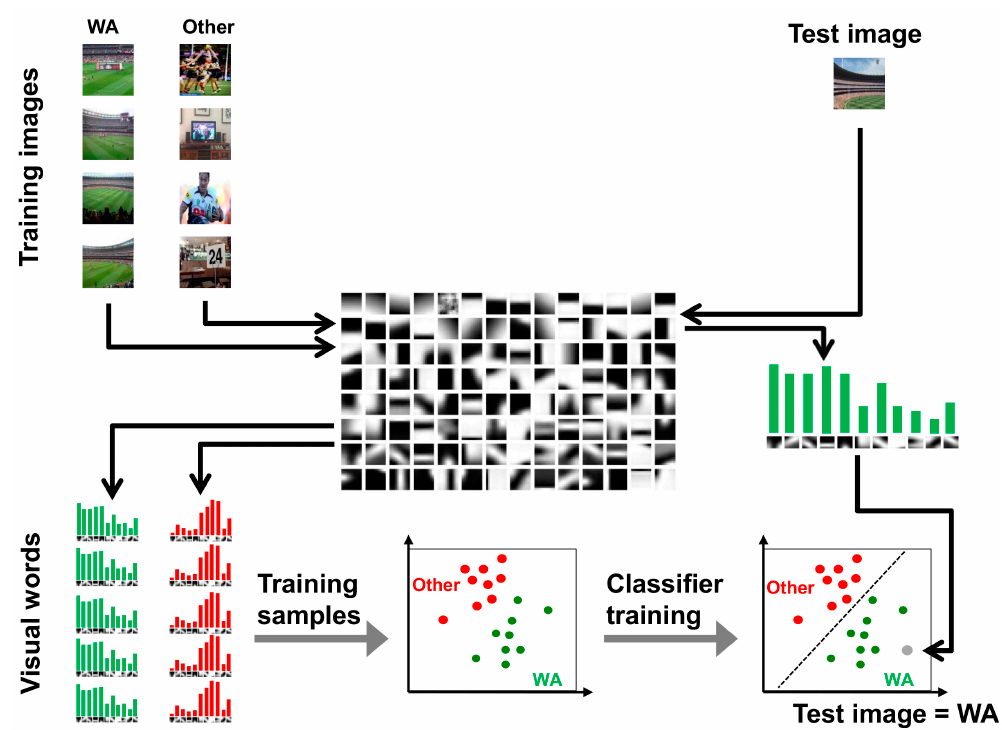
Figure 2. Workflow for the bag-of-words approach for categorizing WA.